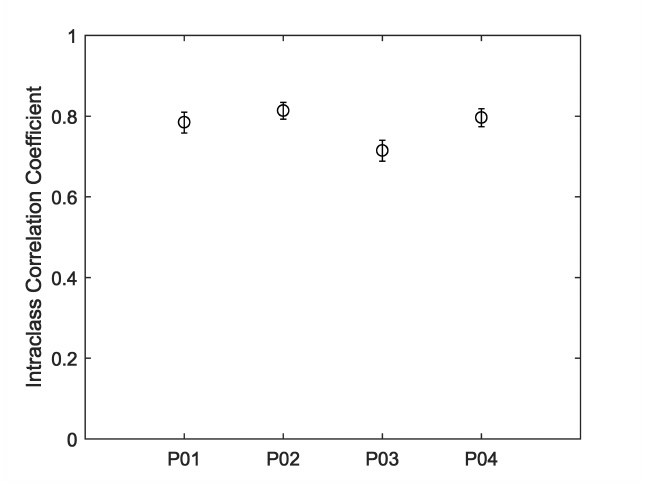
Figure 6. ICC for each device compared with ECG chest strap reference recordings with 90% confidence intervals for treadmill activities.